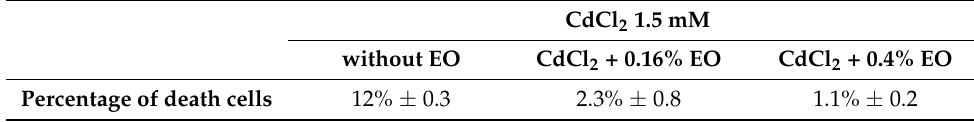
Table 2. Percentage of dead cells from the total within the L. riparium gametophytes treated without EO, with 0.16% and with 0.4% of EO, and, after, with CdCl 2